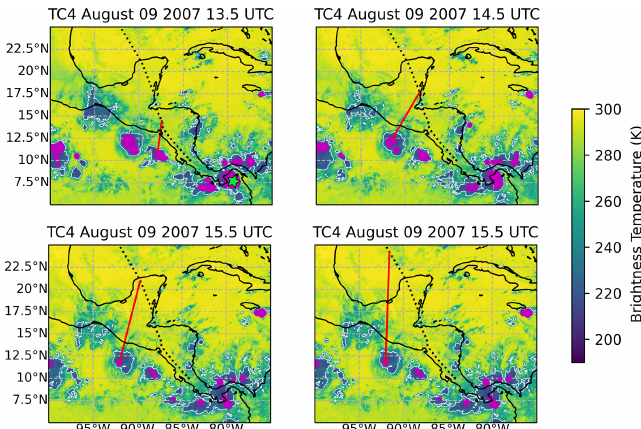
Figure A2. Four snapshots of brightness temperature are shown that overlap an example flight from TC4. The dotted black line shows the flight track. In each snapshot, a red line extends between a point along the flight track that is closest in time to the snapshot shown and the nearest deep convective core to that point. Pink dots indicate convective cores with brightness temperatures below 210K. The green star in the upper left plot is the only point that is below 200K. The white contours surround areas with brightness temperatures below 235K.